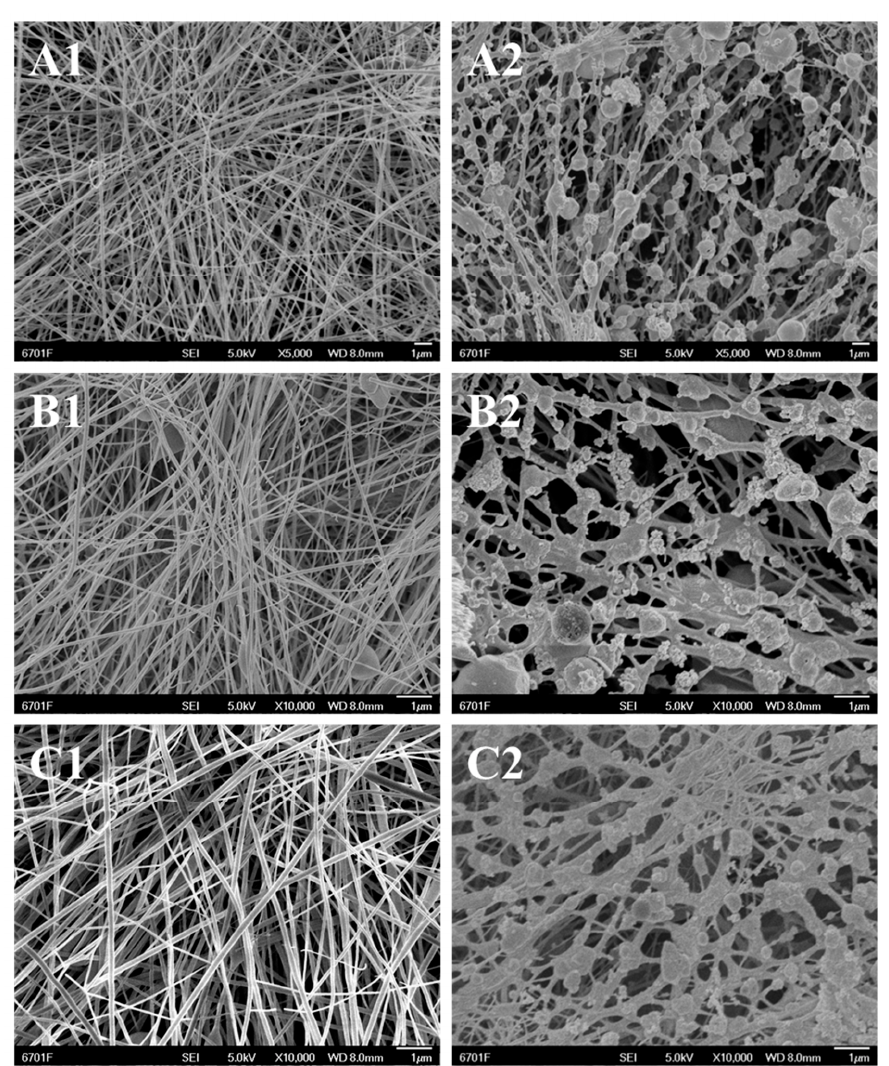
Figure 5. The SEM images of spinning membrane ( A1 : quercetin; B1 : glycyrrhizic; C1 : α -mangostin); and after sampling ( A2 : quercetin; B2 : glycyrrhizic; C2 : α -mangostin). and after sampling ( A2 : quercetin; B2 : glycyrrhizic; C2 : α